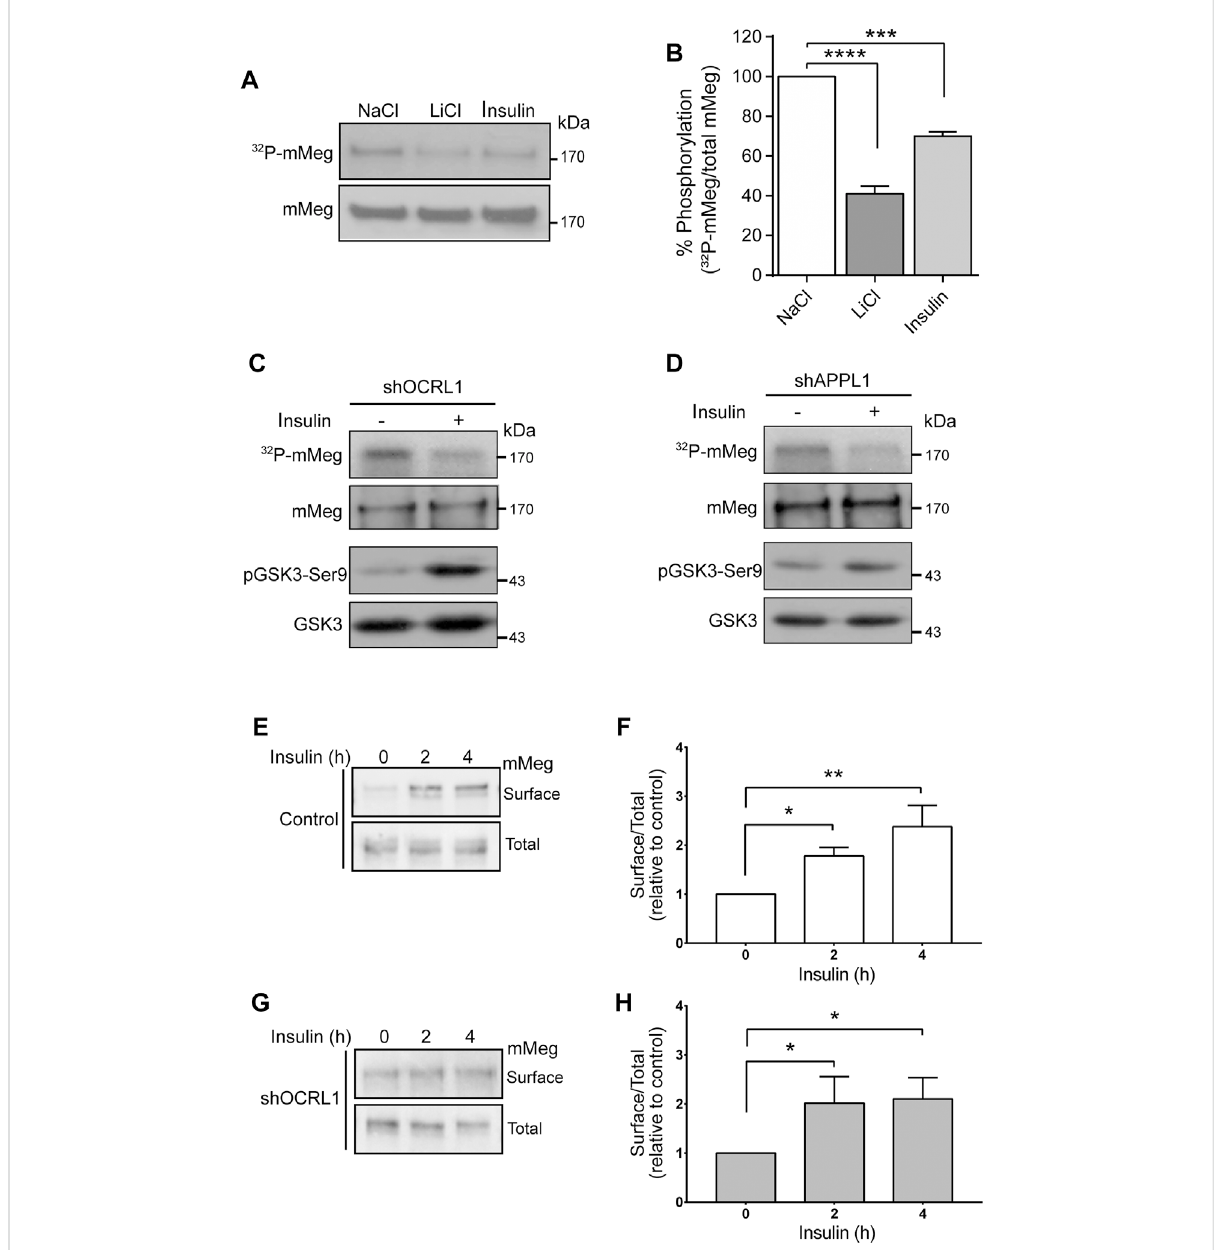
FIGURE 6 InsulindecreasesmegalinphosphorylationandincreasesmegalinsurfaceexpressionincontrolandLScellularmodels. (A) mMeg-LLC-PK1cells treated with NaCl (50 mM), LiCl (50 mM) or insulin (100 nM) were labeled [ 32 P]-orthophosphate for 2 h at 37 ° C, followed by immunoprecipitation of megalinwithananti-megalincytoplasmicdomain.TheimmunecomplexeswereanalyzedbySDS-PAGEandvisualizedbyautoradiography.Aliquots of whole-cell lysates wereused to detect mMeg by western blot. (B) Graph corresponds to the percentageof phosphorylated mMeg related to the total of NaCl, LiCl or insulin-treated cells. Data are expressed as the means ± SEM of N = 3 independent experiments (ANOVA, **** p < 0.0001, *** p < 0.001). Phosphorylation assays were performed in OCRL1 (C) or APPL1 (D) silenced cells in the presence or the absence of 100 nM insulin. ImmunoprecipitatedradiolabeledmMegwasevaluatedbyautoradiography.TotalmMegandGSK3ß(totalandphosphorylatedforms)weredetected by western blot. (E,F) Control or (G,H) OCRL1 silenced cells were serum-starved for 2 h before the incubation with 100 nM insulin by the indicated period of time. Cells werebiotinylated to determine thesurface levels of mMeg. The whole lysates were used for total receptor levels. Samples were analyzed by western blot. The graphs shows surface vs. total ratio of mMeg expression levels relative to control time 0. N = 4; ANOVA, * p < 0.05, ** p <